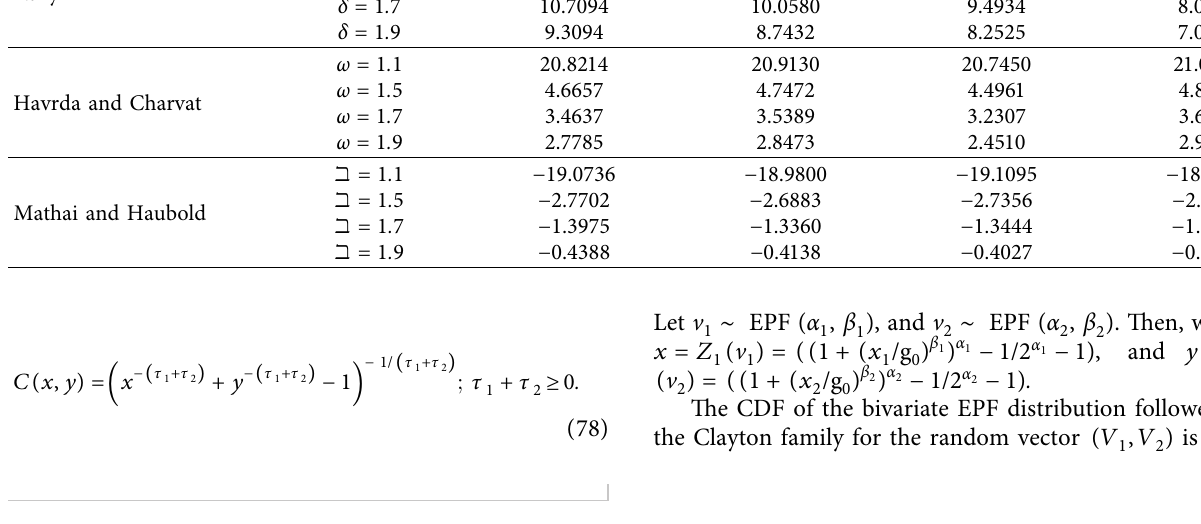
Table 3: Numerical analysis for R´enyi, Havrda and Charvat, and Mathai and Haubold entropy measures. Entropy Int.